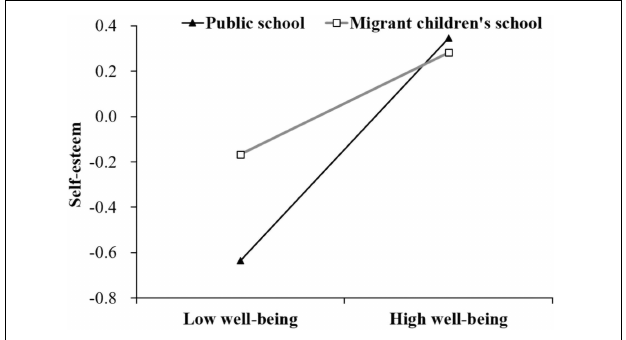
FIGURE 3 | School type moderates the relationship between self-esteem (T1) and wellbeing (T1) for public school and migrant school